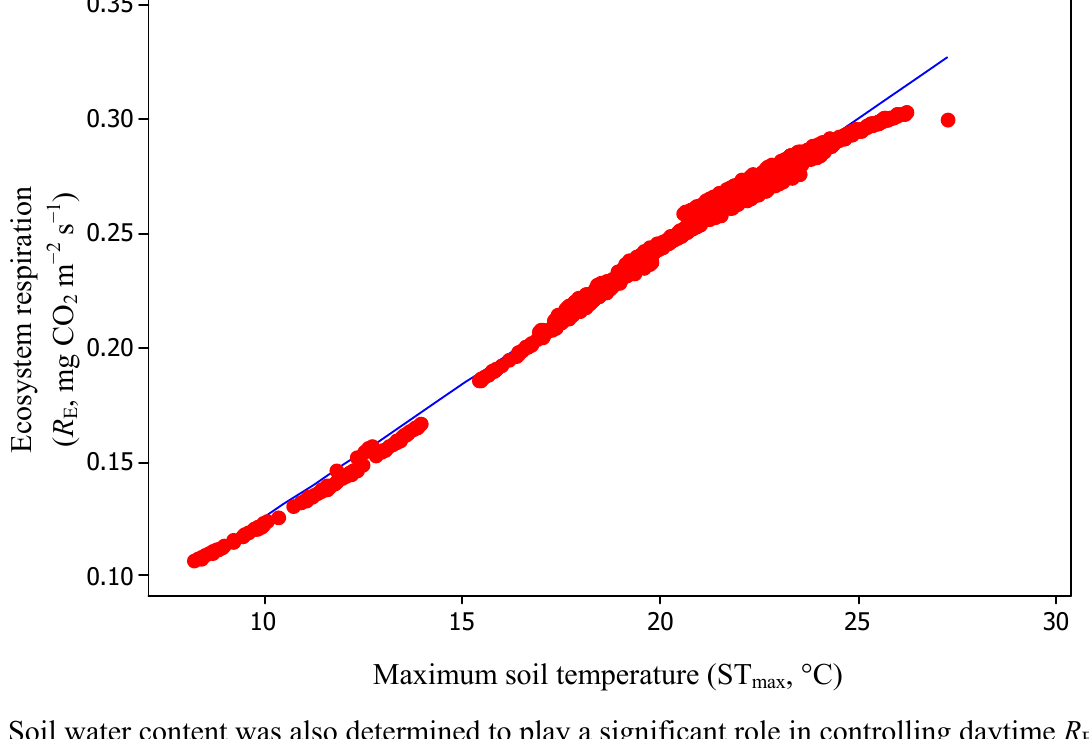
Figure 11. A comparison of ST Yenicaga peatland ( R 2